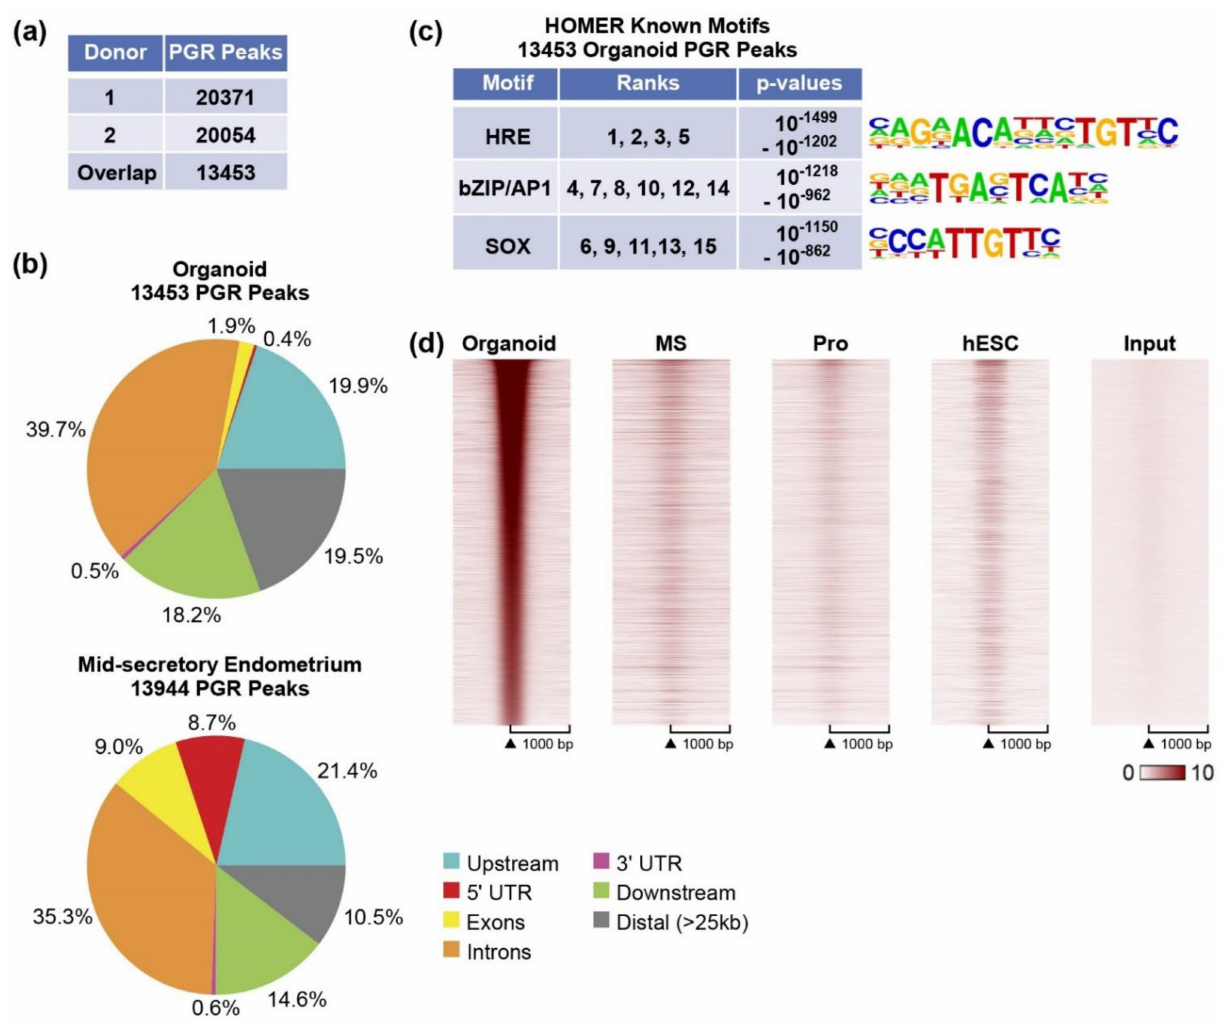
Figure 2. PGR cistrome of organoids. ( a ) Summary of PGR peaks in both donors; ( b ) PAVIS analysis showing locations of PGR peaks in mid-secretory endometrium and organoids. ( c ) HOMER known motif analysis. Summaries of the top 15 HOMER known motifs enriched in PGR peaks. The ranks of each motif, as determined by p -value, along with the range of p -values covered by the ranks are indicated. Motif logos are shown. ( d ) Heatmap indicating PGR ChIP signal centered on PGR locations ( ± 1 kb) in organoids. MS: mid-secretory endometrium, Pro: proliferative